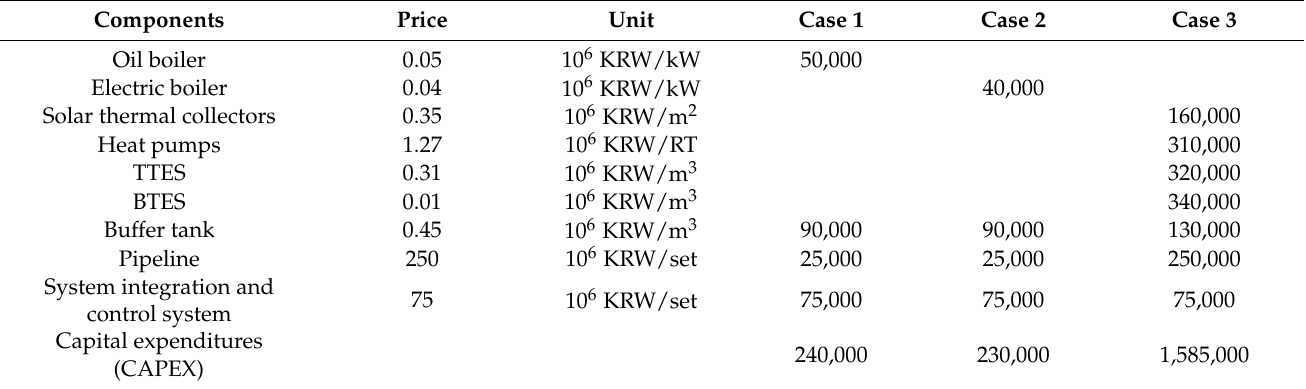
Table 2. Investment cost of the